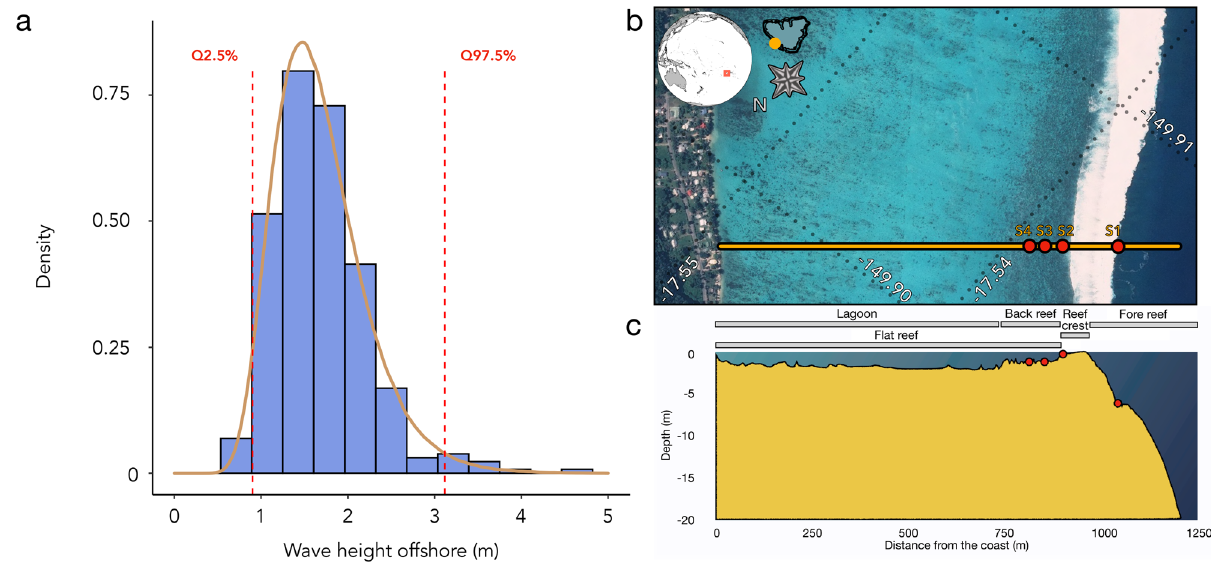
Figure 2. ( a ) Histogram of the offshore wave height (m) at Ha’apiti, Mo’orea (French Polynesia) in 2016. ( b ) Aerial view of Ha’apiti (WorldView-3 imagery) with an outline of the wave transect and sensor location. The ecological sampling took place near the S1 location c. Topographic cross-section of the wave transect and position of the sensors on the sea bottom.